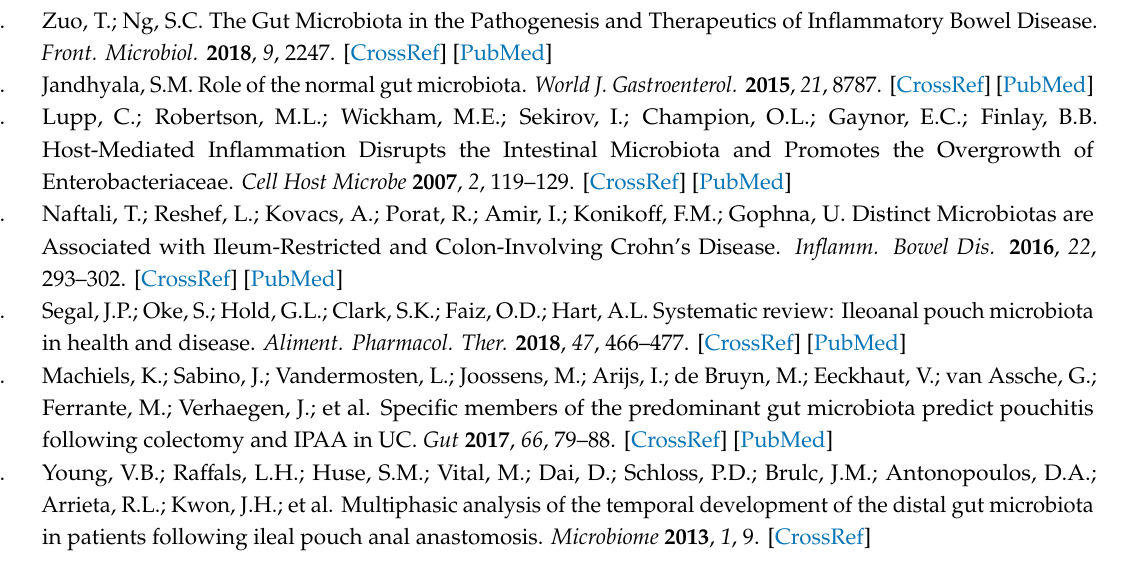
Figure S1: Alpha diversity di ff erences between all groups. Data represent Fisher alpha diversity indices at the OTU level based on 16S rRNA profiling of the V4 region. No significant di ff erence was observed between Pouch_active and Pouch_inactive, and UC_active and UC_inactive groups. Sample sizes were 6, 13, 9, 13, 7 and 8 for FAP, Healthy, Pouch active, Pouch inactive, UC active and UC inactive groups, respectively. Central horizontal bars represent median values. For details, see Table S2. Figure S2: Shannon (a) and inverse Simpson (b) alpha diversity indices at the OTU level based on 16S rRNA profiling of the V4 region. Sample sizes were 6, 13, 9, 13, 7 and 8 for FAP, Healthy, Pouch active, Pouch inactive, UC active and UC inactive groups, respectively. Central horizontal bars represent median values. For details, see Table S2. Table S1: Primer sequences, Table S2: Diversity values and Wilcoxon test results. Table S3: Pairwise permANOVA results. Table S4a: Bacterial abundance; Table S4b: Di ff erential abundance. Table S5: Patients all data